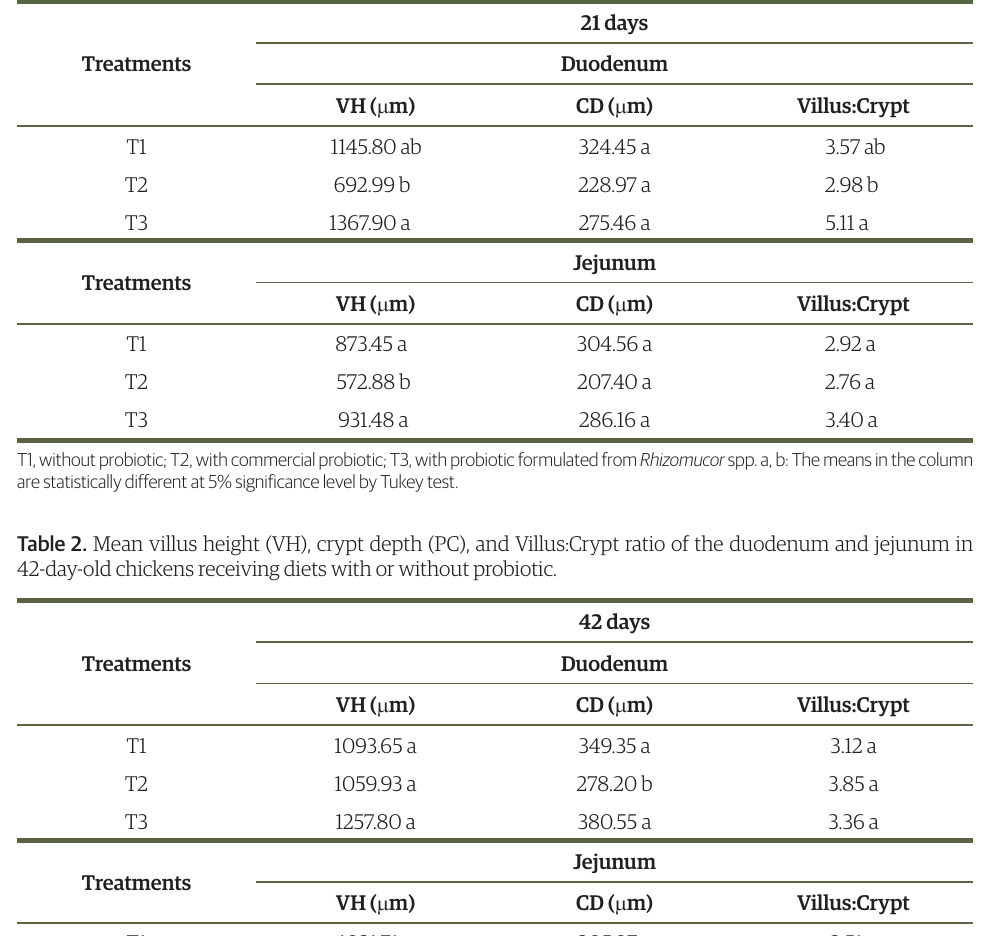
Table 1. Mean villus height (VH), crypt depth (PC) and Villus:Crypt ratio of the duodenum and jejunum in 21-day-old chickens receiving diets with or without probiotic.